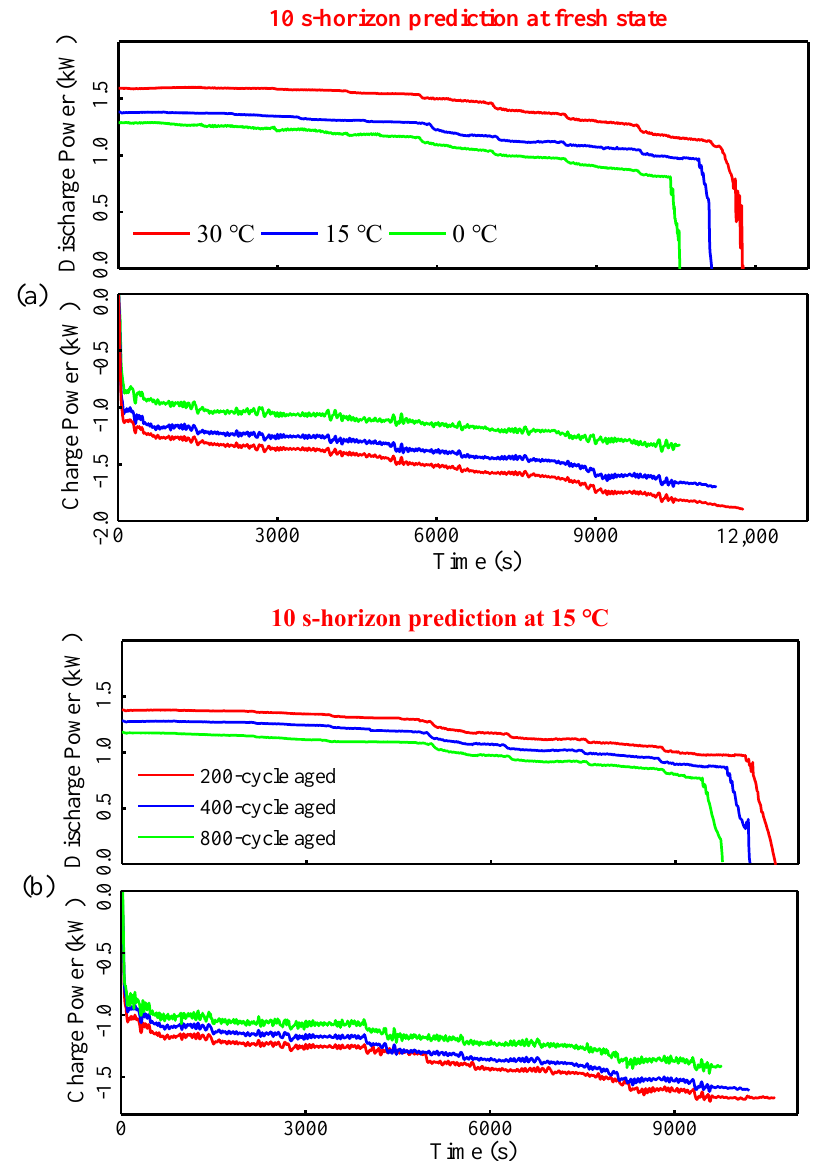
Figure 6. ( a ) 10 s power at different temperatures at fresh state; ( b ) 10 s power at different aging levels at 15 °C .